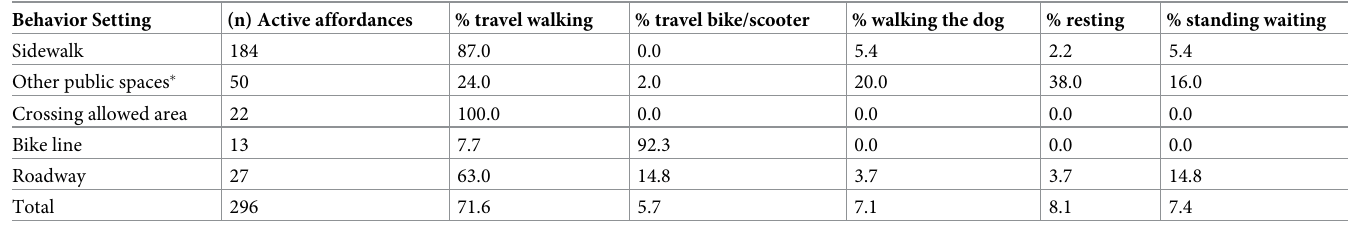
Table 3. Behavior setting and active affordances.